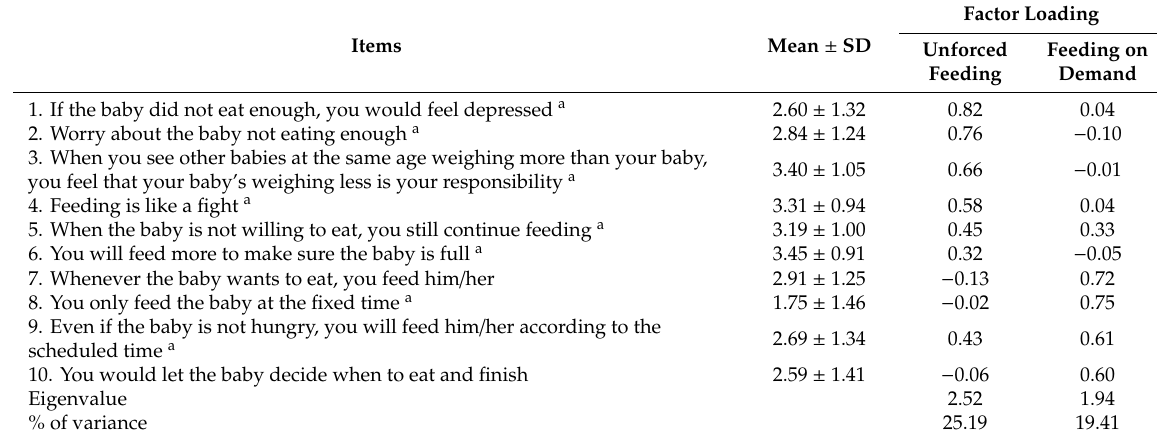
Table 2. Exploratory factor analysis of the responsive feeding scale at 3 months postpartum ( n = 438). Items Mean ± SD